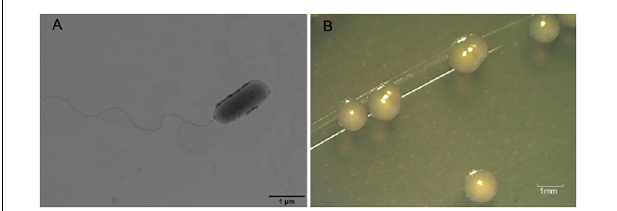
FIGURE 1 | Transmission electron microscopy (TEM) image of endophytic bacterium L10 and its colonies on LB agar medium. (A) Transmission electron microscopy (TEM) image of rod-shaped endophytic isolate L10. (B) The circular and smooth colonies of endophytic bacterium L10 on LB agar